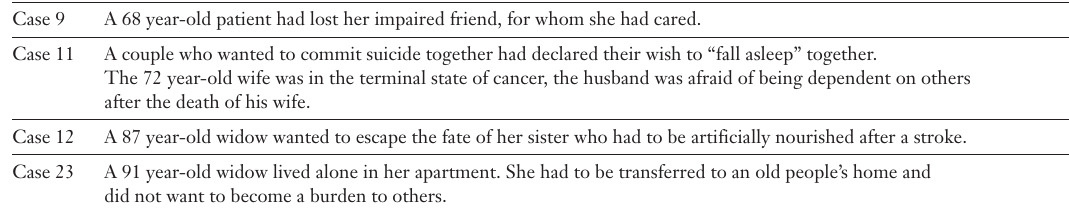
Not medical reasons for the wish to